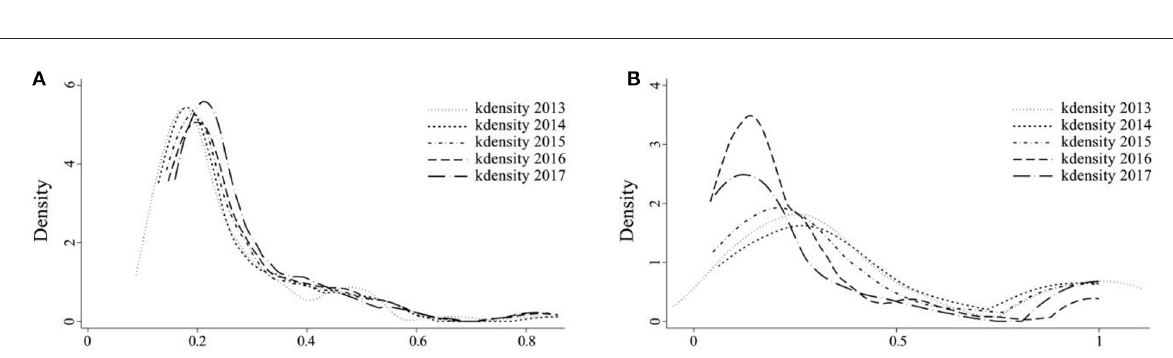
curve (Kuznets curve), with the years 2014 and 2016